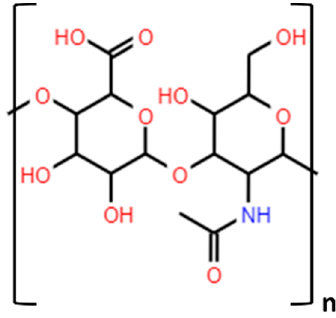
Figure 6. Chemical structure of hyaluronic acid.